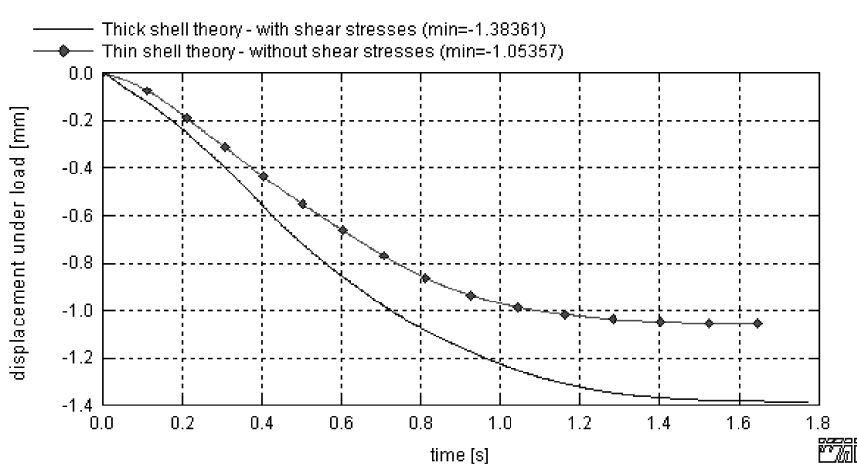
Fig. 9. Displacement time histories (displacement under